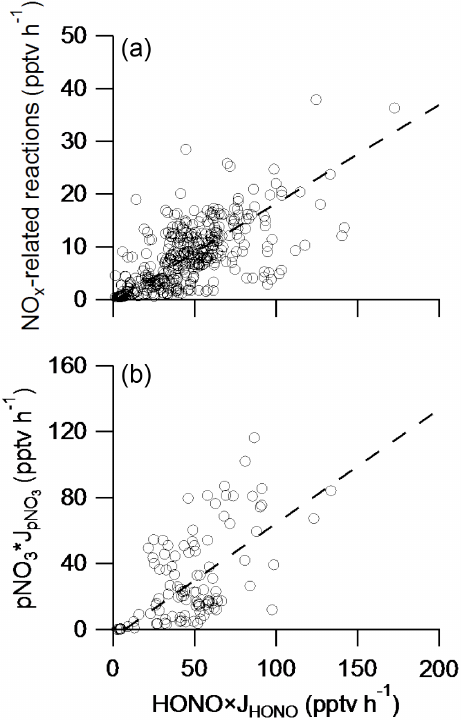
Figure 5. Correlation analysis of the main HONO sink (“HONO × J HONO ”) with the contribution from NO x -related re- actions (a) and with the contribution from particulate nitrate pho- (b) in the southeastern US during the tolysis, p NO 3 × J p NO 3 NOMADSS 2013 summer study. The line represents the Deming least-squares regression (Wu and Yu, 2018) ( r 2 = 0 . 40, intercept = − 0.51 and slope = 0.19 for (a) ; r 2 = 0 . 34, intercept = − 5.0 and slope = 0.69 for (b) ).